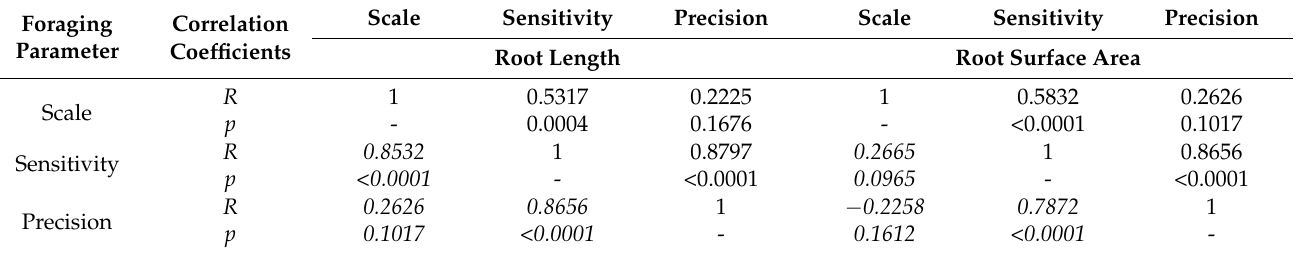
Table 4. Pearson correlation between pairs of parameters assessing root foraging behavior among scale, sensitivity, and precision in Bidens pilosa L. and Plantago asiatica